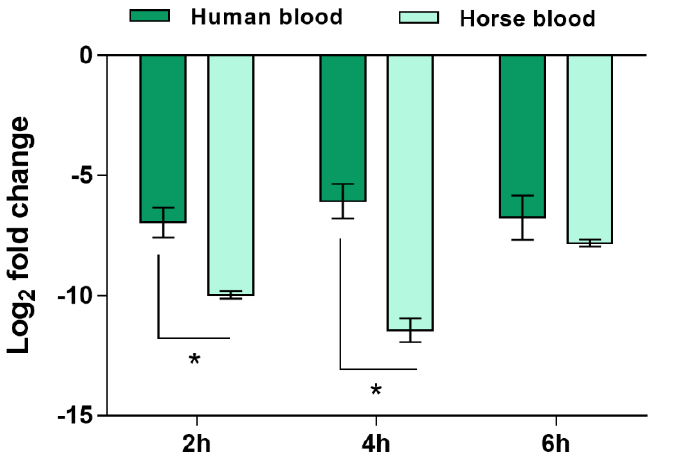
Figure 3. Evaluation of the expression of the gene SERP2441 in human and defibrinated horse blood over time. The bars represent the mean and the standard error of the mean of two independent assays ( n = 2). These experiments were performed in strains IE214 (clinical isolate) and SECOM0020A.1 (commensal isolate). Statistical differences between groups in each time point were analyzed with the unpaired t-test. * p < 0.05.